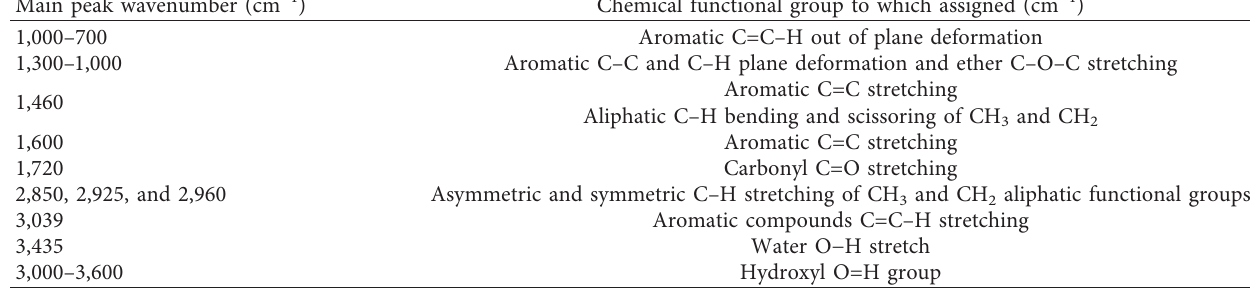
Table 2: IR absorption wavenumber of soot and polyaromatic hydrocarbons summarized from the literature [8, 13, 14, 66]. Main peak wavenumber (cm − 1 ) Chemical functional group to which assigned (cm − 1 )